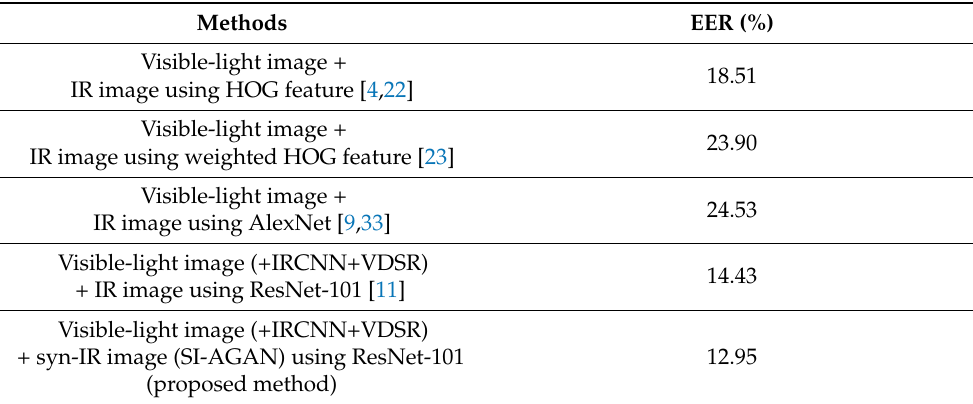
Table 16. Comparison of gender recognition accuracies with our method and previous methods for the SYSU-MM01